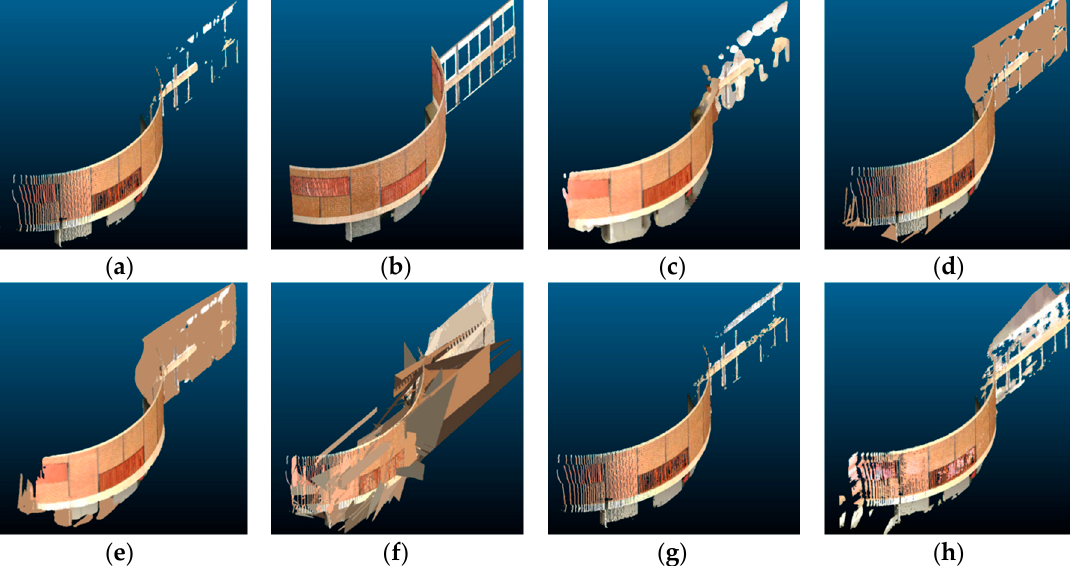
Figure 12. Point cloud scene completion results for the Van Leer building, visualized in 3D: ( a ) input point cloud, ( b ) target ground truth, ( c ) Poisson reconstruction, ( d ) hole-filling, ( e ) hybrid, ( f ) plane-fitting, ( g ) partial convolution, and ( h ) proposed.